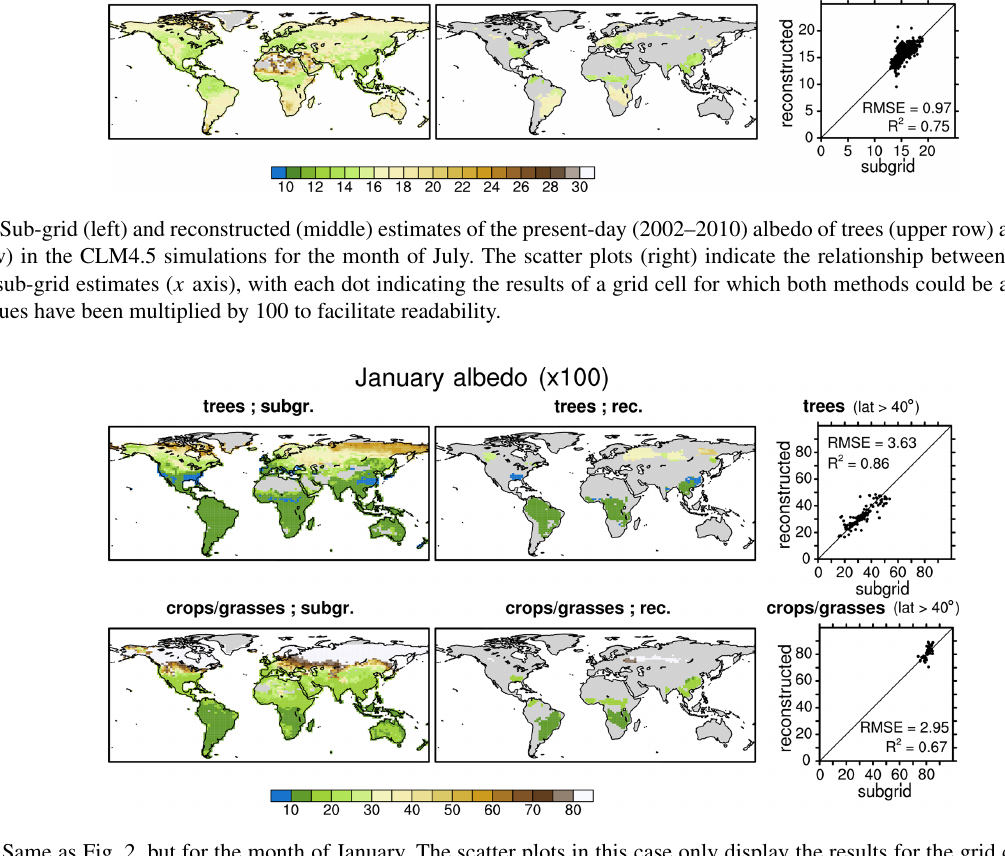
(0.037 for trees and 0.0295 for crops–grasses as indicated in the right panel), leading to global RMSEs of 0.019 and